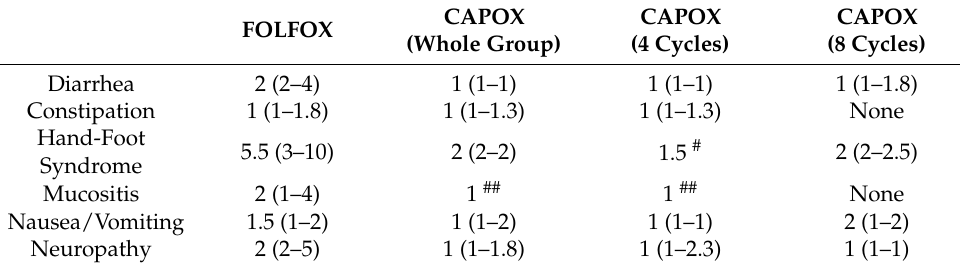
Table 3. Treatment Cycle at the Onset of Chemotherapy-Induced Toxicity.